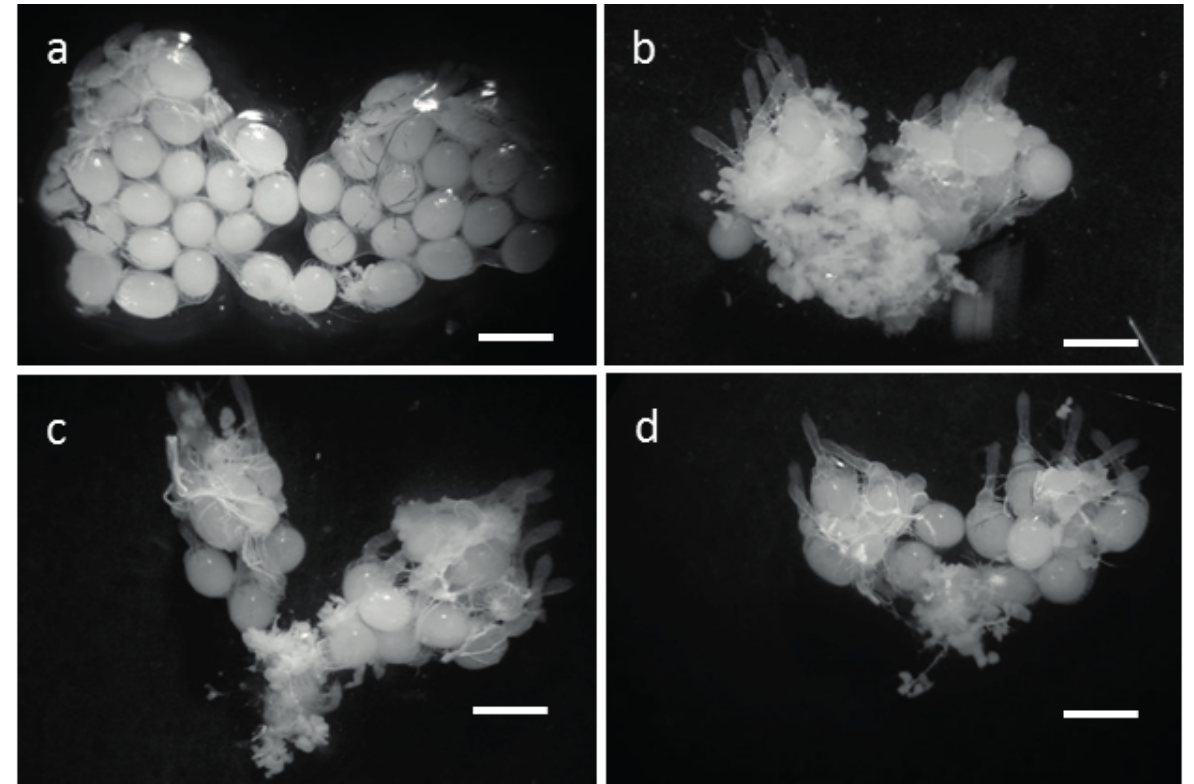
Figure 1 - Ovary of Podisus nigrispinus (Hemiptera: Pentatomidae) in treatments: control sample ( a ), atrazine ( b ), mixture (atrazine + nicosulfuron) ( c ), nicosulfuron ( d ). Bars = 2